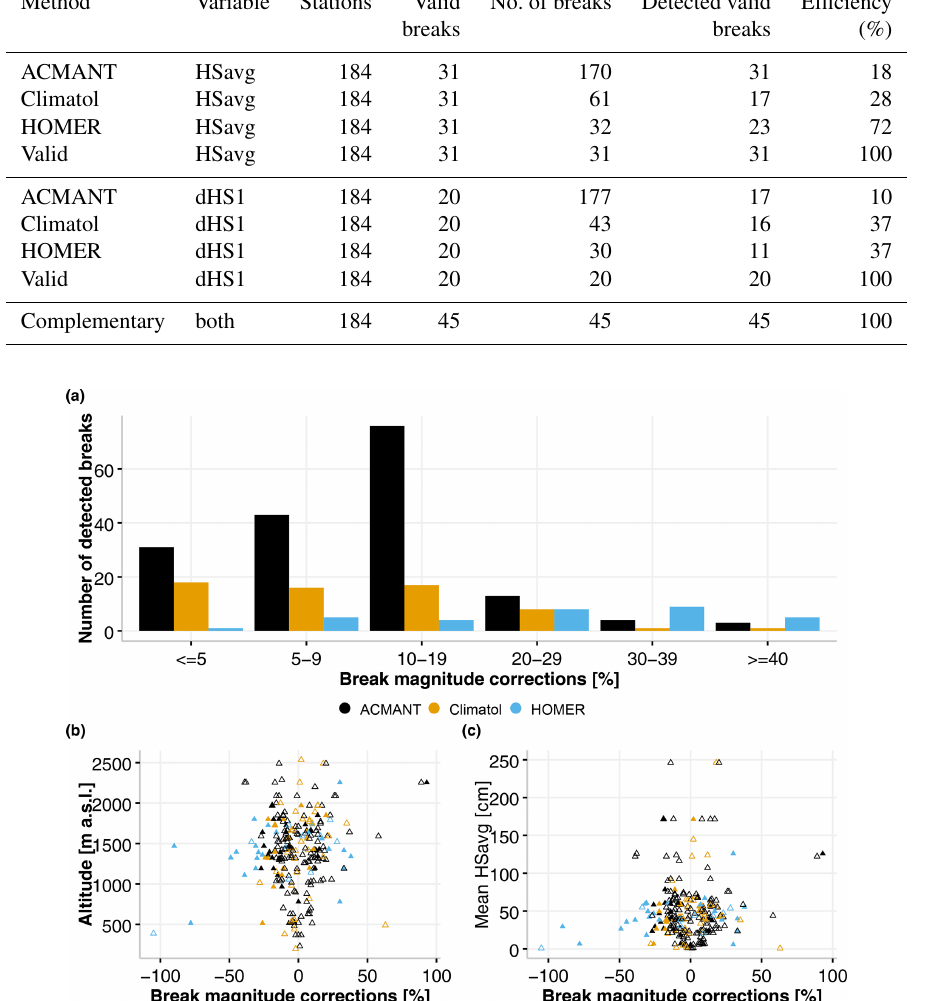
Figure 3. (a) Absolute break magnitude corrections and their distribution for ACMANT, HOMER, and Climatol. (b) Break magnitude corrections versus station altitude. (c) Break magnitude corrections against mean HSavg. Valid break points are